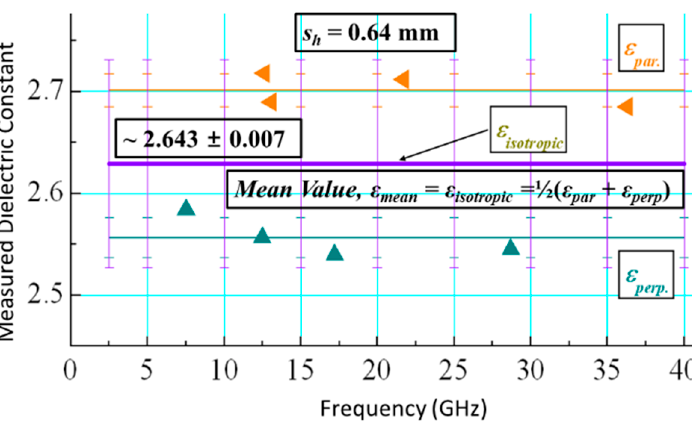
Figure 5. PDMS dielectric constant’s measured values.